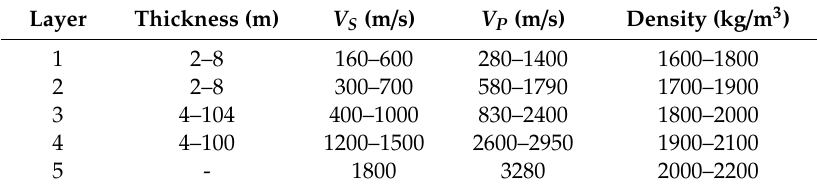
Table 3. Initial inversion parameter ranges for